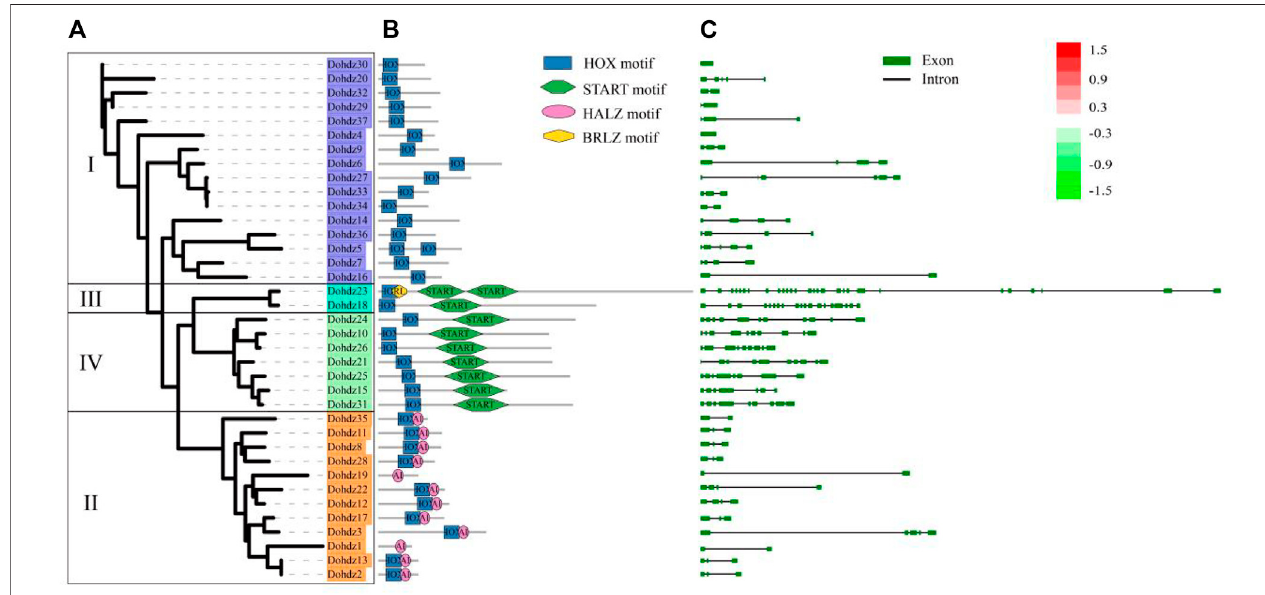
FIGURE 2 | Phylogenetic relationships (A) , conserved motif compositions (B), and exon – intron structure (C) of these 37 HD-ZIP genes in D. of fi cinale . The phylogenetic treewasconstructed basedon thefull-length protein sequences using Figtreesoftware;theconservedmotifswerepredictedusing the SMARTdatabase. Each motif is represented by a different colored box; Gene exons and introns were indicated by boxes and